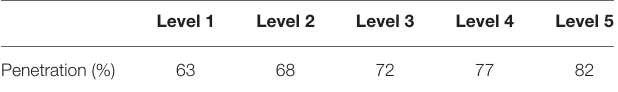
TABLE 5 | Wind penetration levels.